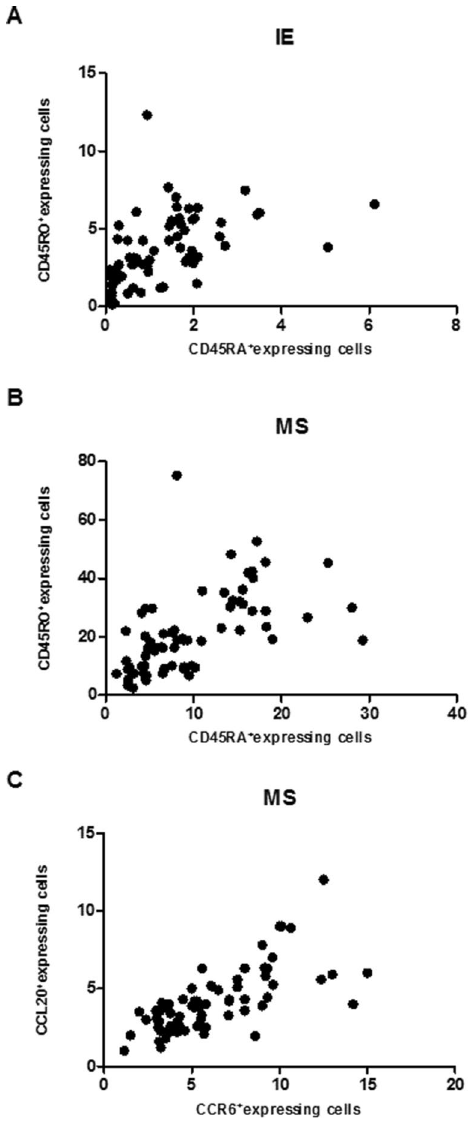
Figure 5. Correlation among inflammatory cells in cervical lesion. ( A ) CD45RA + and CD45RO + cells distribution in IE and ( B ) MS. ( C ) CCL20 + and CD45RO + cells distribution in MS. Spearman’s rank correlation was used to identify association between the cell markers. P value was calculated using the Spearman